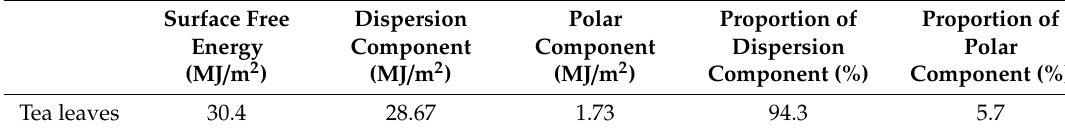
Table 3. Surface free energy and other components of tea leaf surfaces.